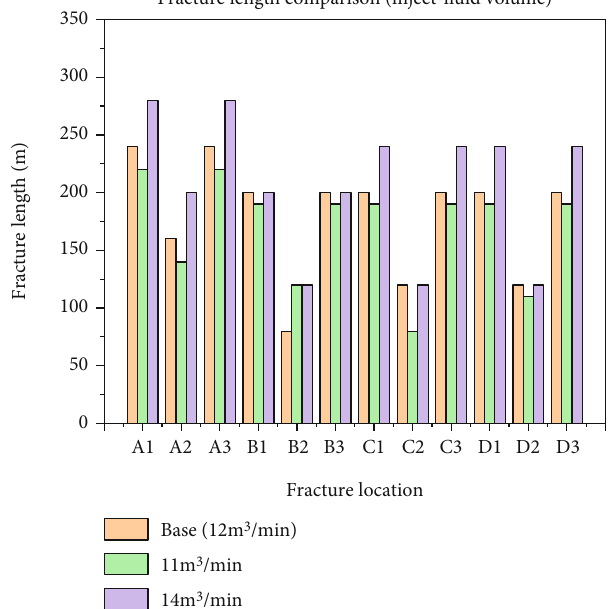
Figure 8: Comparison of fracture length for scenarios with di ff erent fracturing fl uid injection rates per